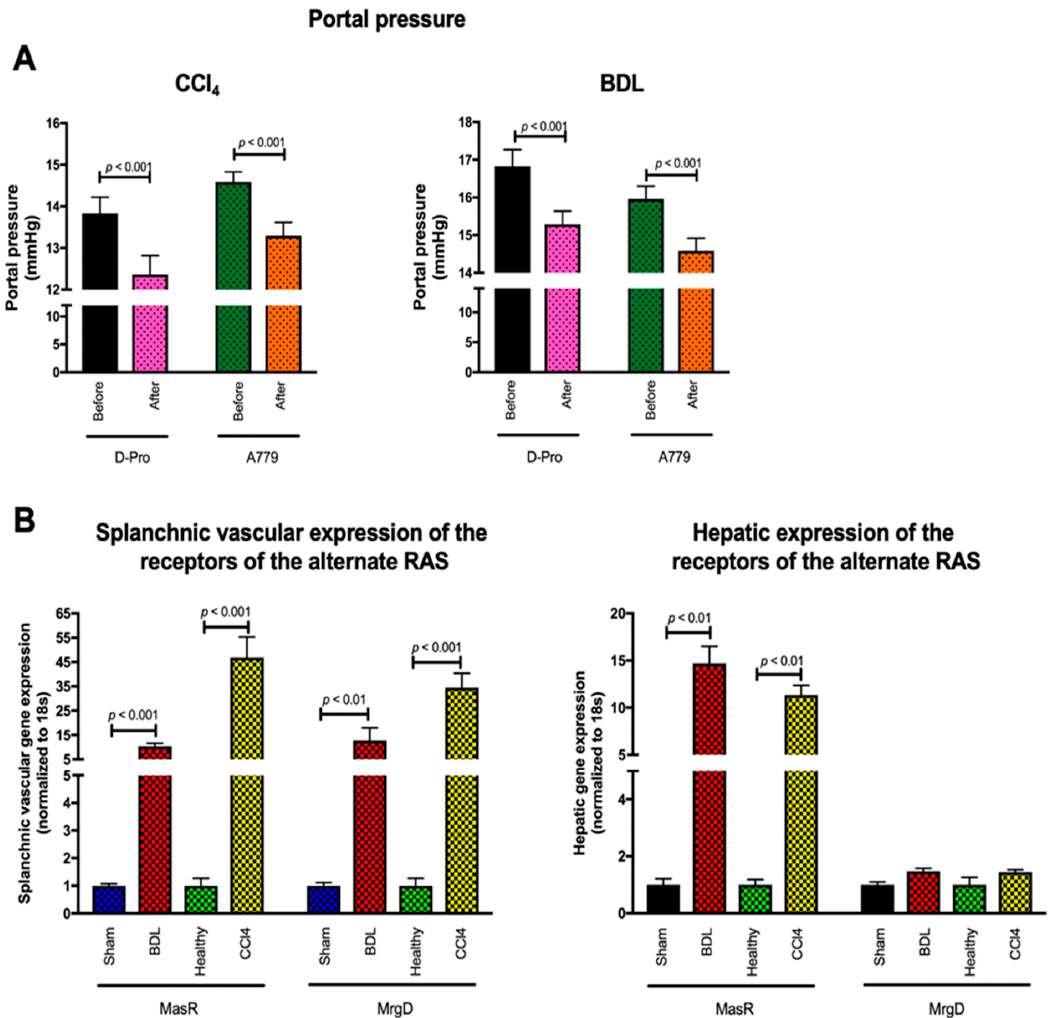
Figure 5. Portal pressure responses to the blockade of the receptors of the alternate renin angiotensin system (RAS) in cirrhotic rat models induced by carbon tetrachloride (CCl 4 ) injections or bile duct ligation (BDL), and splanchnic and hepatic vascular expression of the receptors, MasR and Mas related G protein-coupled receptor type-D (MrgD). ( A ) Portal pressure responses 5 min after a bolus injection of MasR blocker D-Ala7-Ang-(1–7) (A779) (10 µg/kg) or MrgD blocker D-Pro7-Ang-(1–7) (D-Pro) (10 µg/kg) in CCl4 and BDL rats. Both MasR and MrgD blockade produced a significant reduction of portal pressure likely via blocking angiotensin-(1–7)-mediated dilatation of the splanchnic vascular bed. ( B ) Gene expression of MasR and MrgD in cirrhotic mesenteric and hepatic vascular beds of CCl4 and BDL models compared with sham-operated or healthy control livers. In the splanchnic vasculature of cirrhotic rats, both MasR and MrgD are upregulated, suggesting that both these receptors likely play an important role in angiotensin-(1–7)-mediated splanchnic vasodilatation in cirrhosis. Although the MasR is upregulated in the cirrhotic livers, there was no change in the expression of MrgD suggesting that MasR, but not MrgD contributes to the regulation of hepatic vascular resistance in cirrhosis. Adapted from